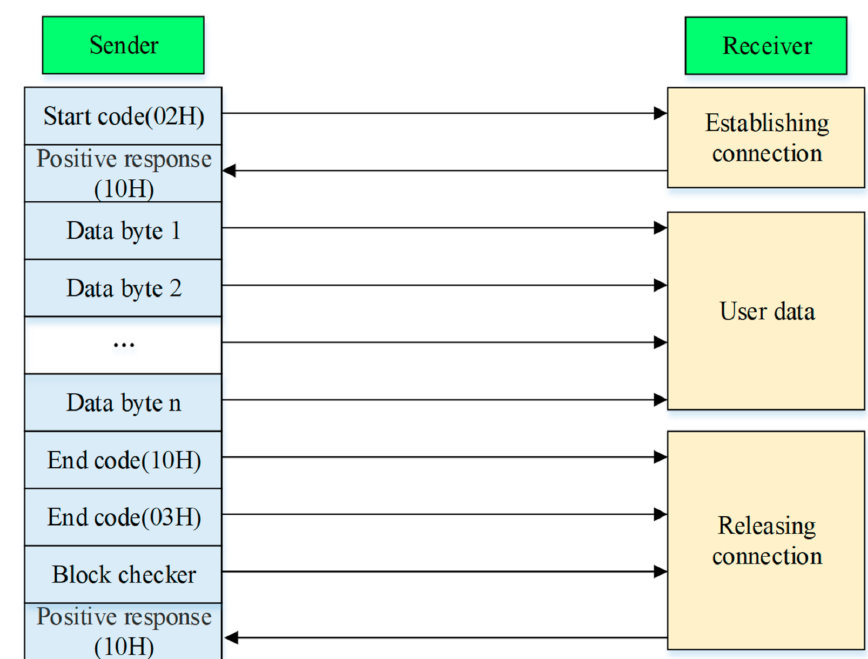
Figure 7. Diagram of 3964(R) protocol communication